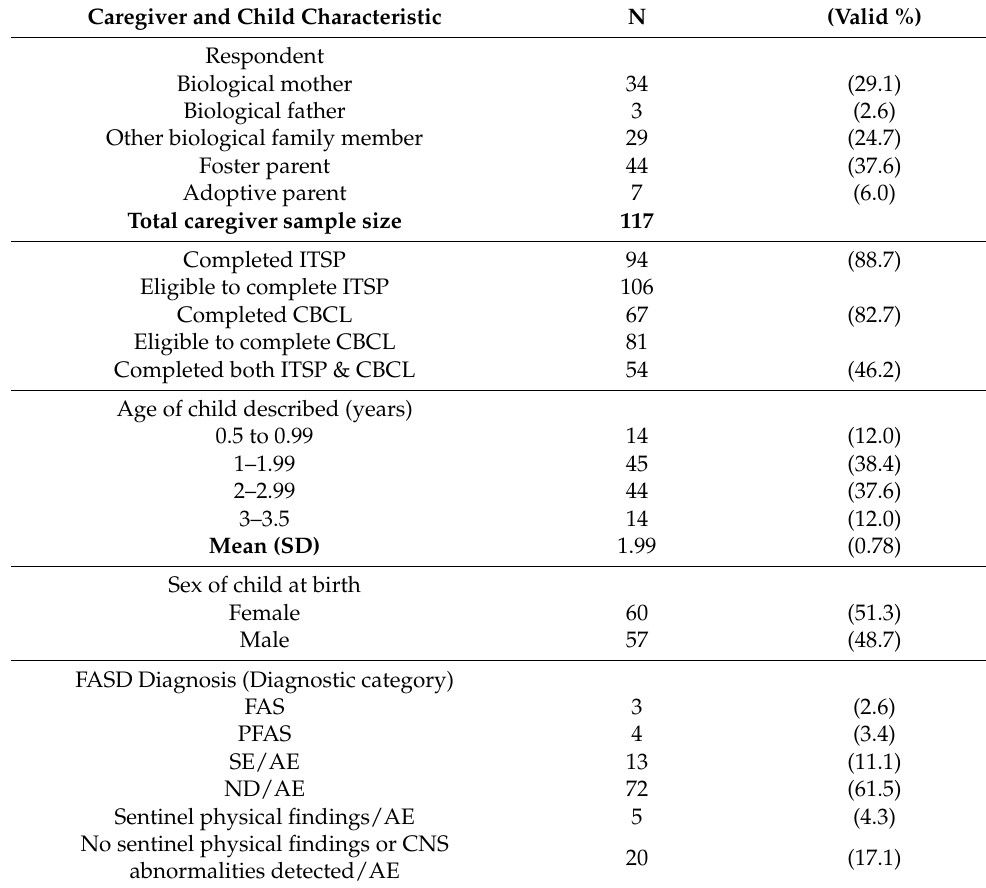
Table 1. Demographic and clinical characteristics of the 117